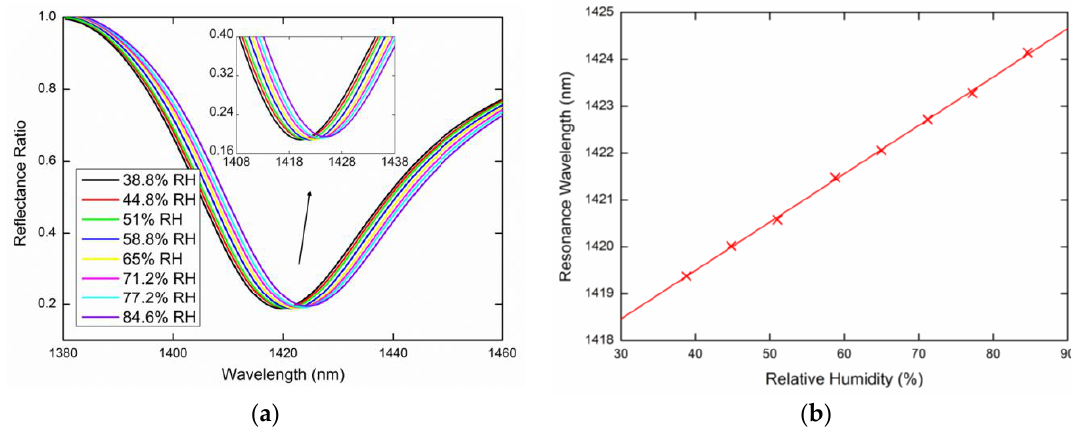
Figure 12. Measured spectral reflectance ratio 𝑅 𝑠 (𝜆) / 𝑅 𝑝 (𝜆) for the external angle of incidence 𝛼 = 16.6° ( a ), the resonance wavelength as a function of the RH with a linear fit ( b ).